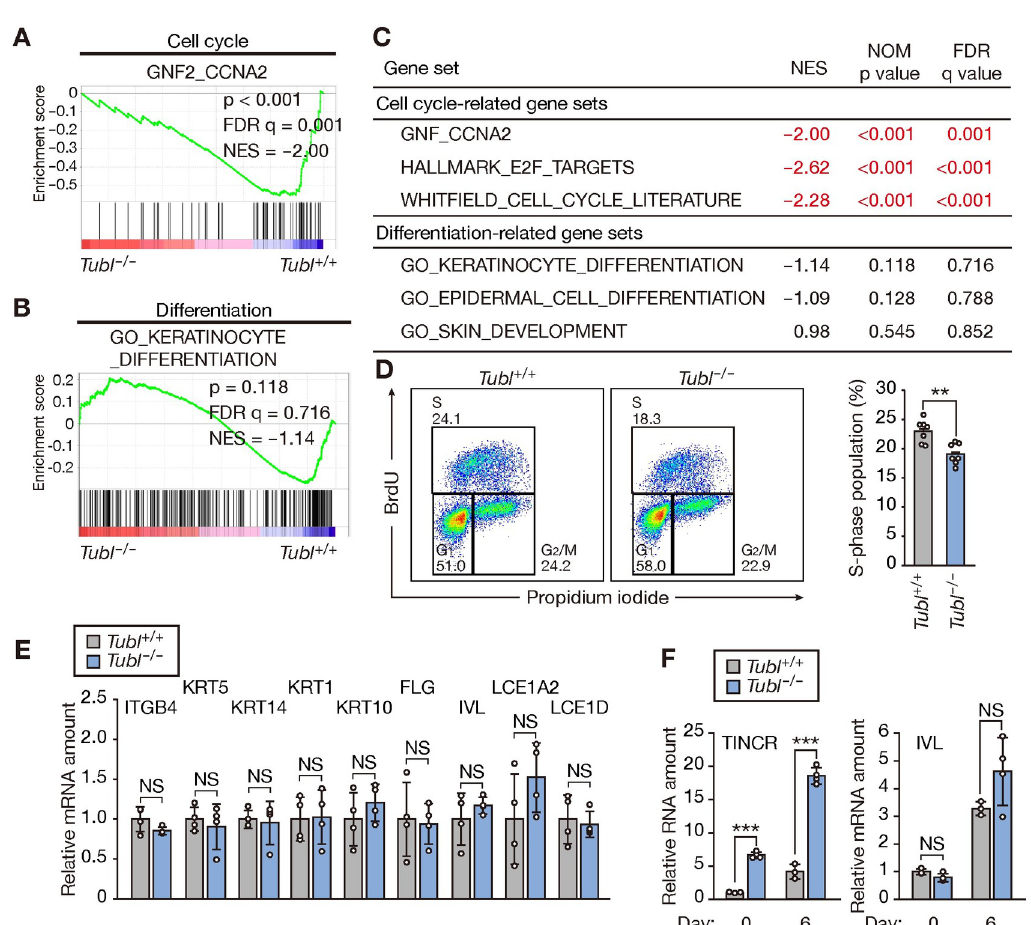
Fig 5. TUBL deficiency delays cell cycle progression in mouse primary keratinocytes. (A, B) GSEA plots for gene sets related to the cell cycle (A) or keratinocyte differentiation (B) constructed from RNA-seq data for the epidermis of Tubl +/+ or Tubl − / − mice at 8 weeks of age. FDR, false discovery rate; NES, normalized enrichment score. (C) Results of GSEA for gene sets related to the cell cycle or keratinocyte differentiation. NOM, nominal. (D) Flow cytometric traces and quantification of BrdU incorporation in primary keratinocytes from Tubl +/+ or Tubl − / − mice. Data in the right panel are means ± SD (n = 7 or 8 independent experiments). �� p < 0.01 (Student’s t test). (E) RT-qPCR analysis of keratinocyte differentiation–related gene expression in the epidermis of Tubl +/+ and Tubl − / − mice. Data are means ± SD (n = 4 independent experiments). NS, Student’s t test. (F) RT-qPCR analysis of TINCR and involucrin mRNA abundance in mouse primary keratinocytes established from Tubl +/ + or Tubl − / − mice and subjected to calcium-induced differentiation in vitro for 0 or 6 days. Data are means ± SD (n = 3 or 4 independent experiments). ��� p < 0.005, NS (Student’s t